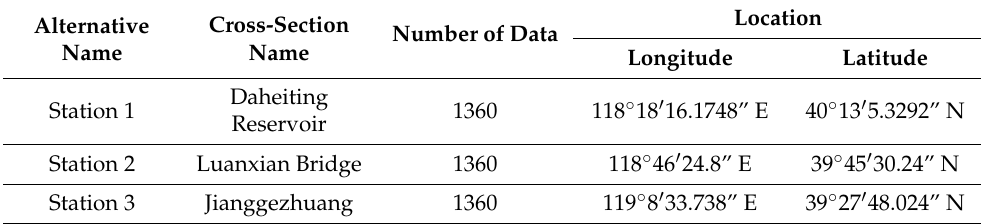
Table 1. Monitoring cross-section name and